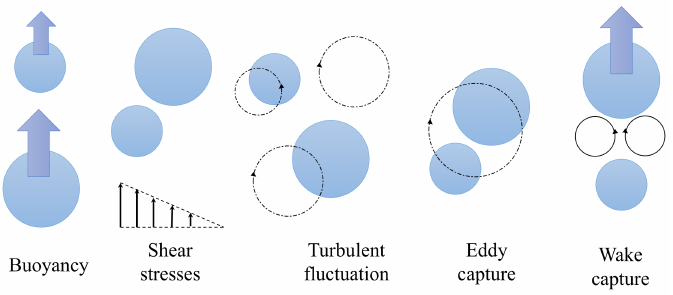
Figure 40. Coalescence